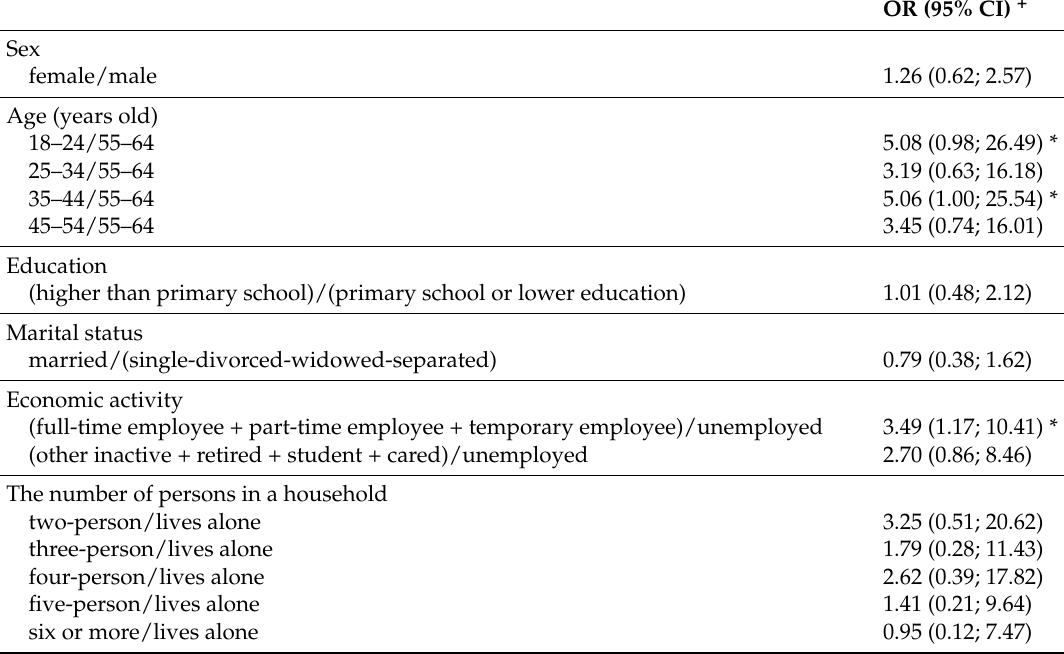
Table 2. Socio-economic status of only-interviewer-reported Roma adults compared to the self-reported Roma according to multivariate logistic